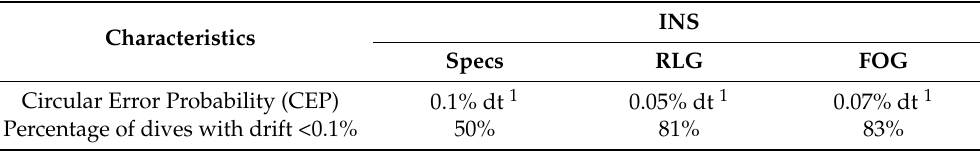
Table 7. Ring laser gyros (RLG) and fibre optic gyros (FOG) comparison [152].